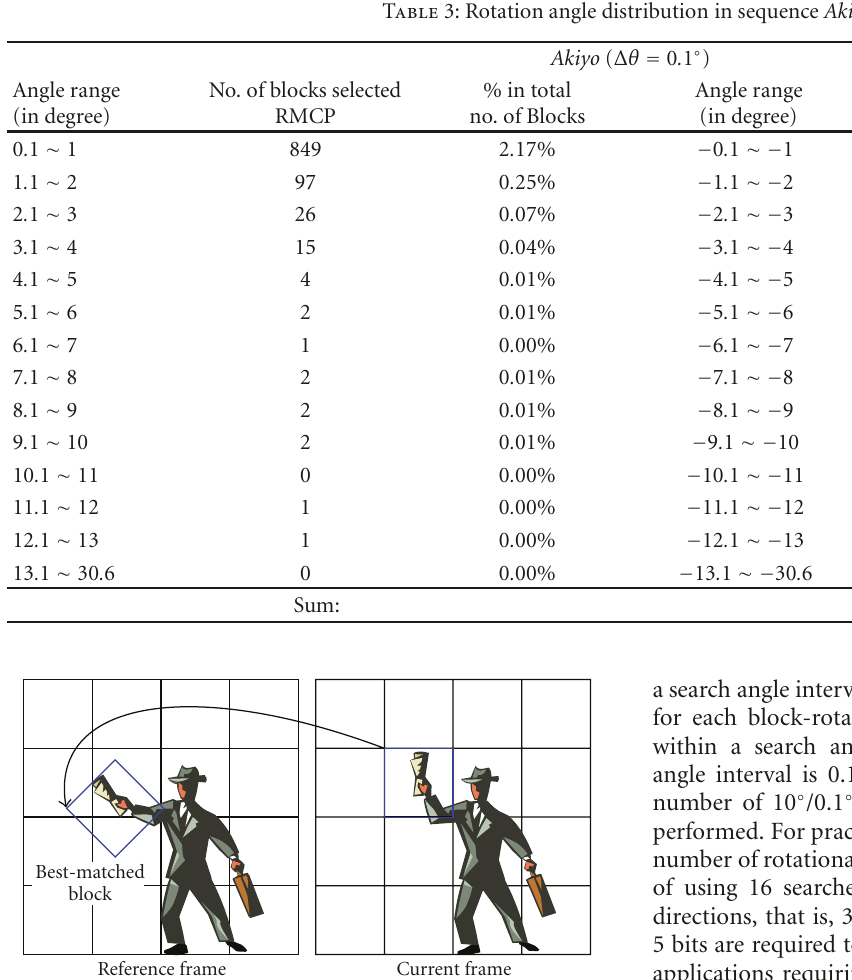
Figure 1: An example of block matching using translational and rotational motion model.